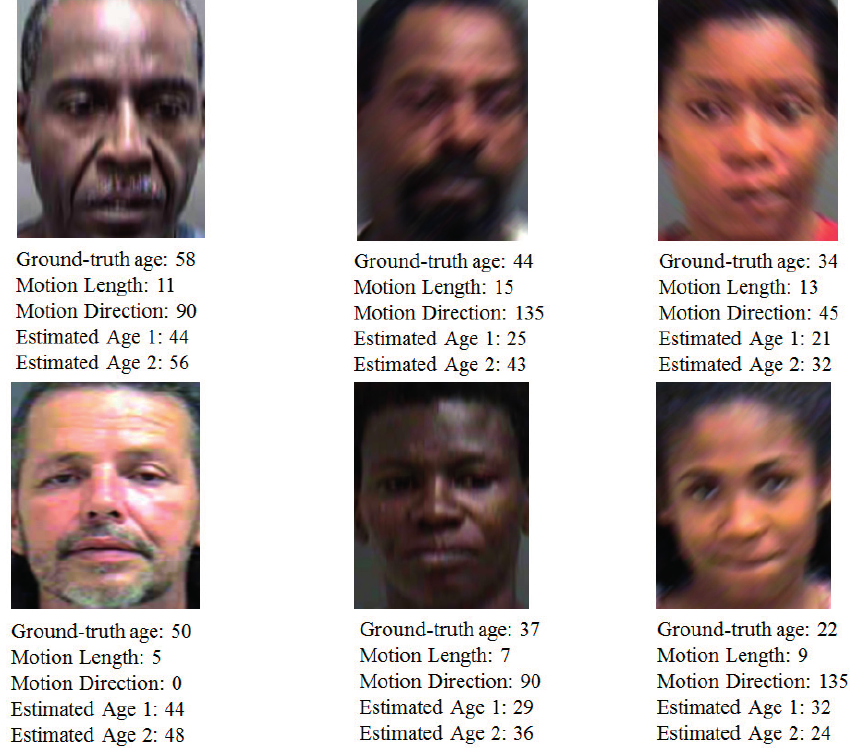
Figure 19. Sample results of estimation process with and without our proposed method